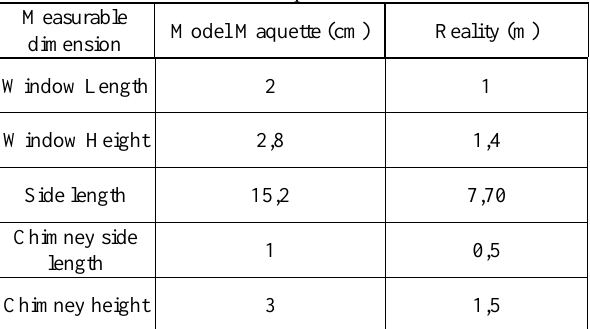
Table 1: Model-maquette’s dimensions